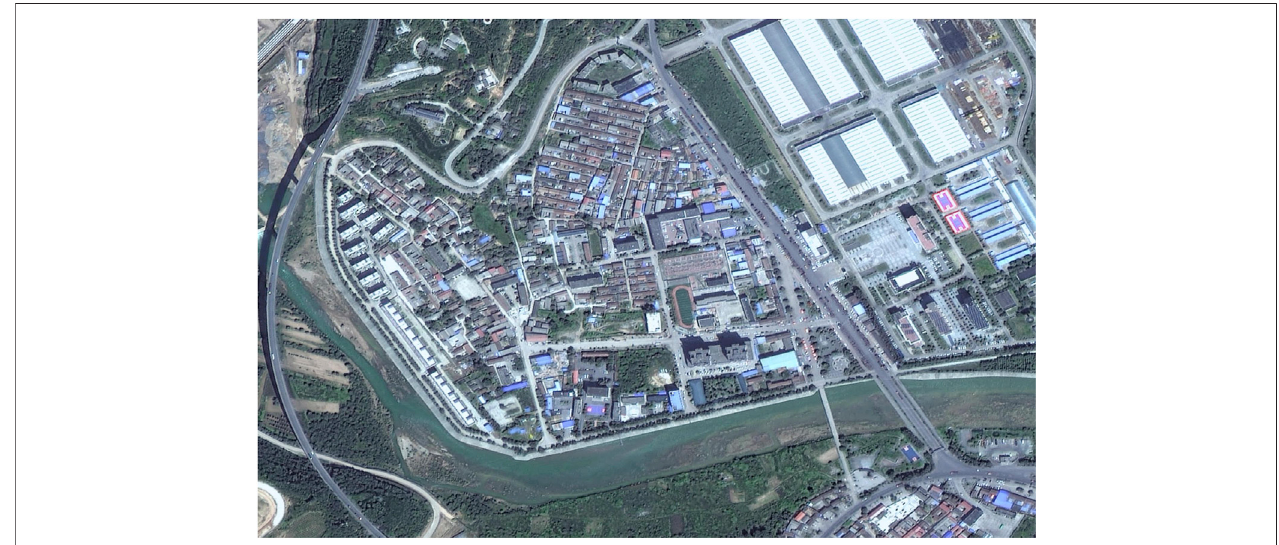
FIGURE 1 | Sur fi cial construction.